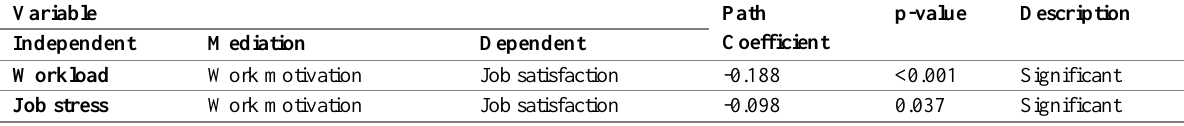
Table 6: Indirect Hypothesis